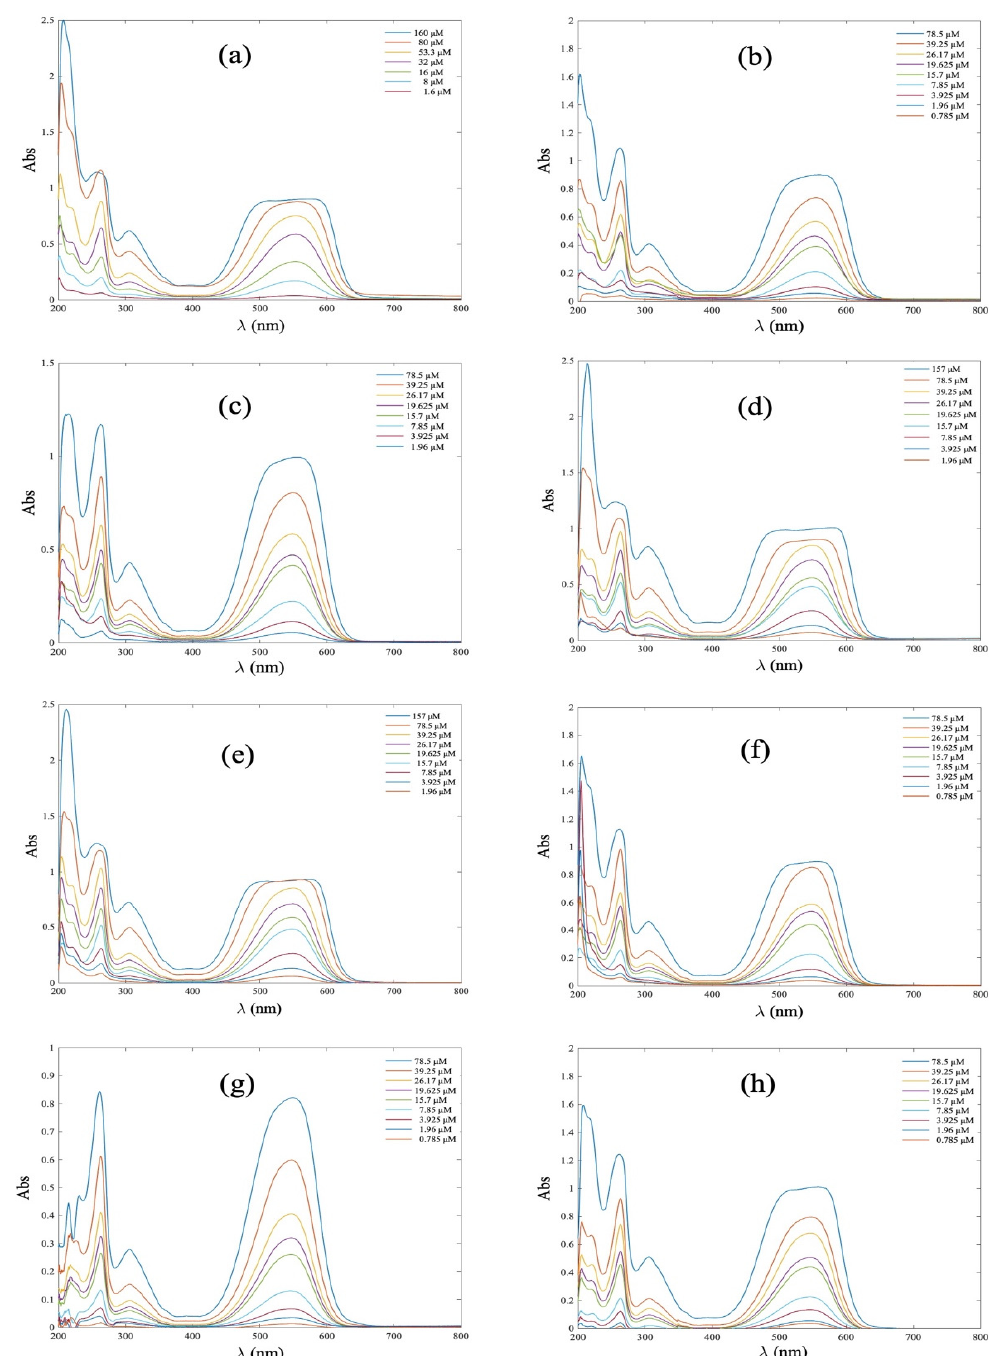
Figure 1. Absorption spectra of NR in ( a ) Methanol, ( b ) Ethan-1ol, ( c ) Propan-1ol, ( d ) Butan-1ol, ( e ) Pentan-1ol, ( f ) Hexan-1ol, ( g ) Heptan-1ol, and ( h ) Octan-1ol. The concentrations of the dilutions are in the range of 0.785–160 μ M.